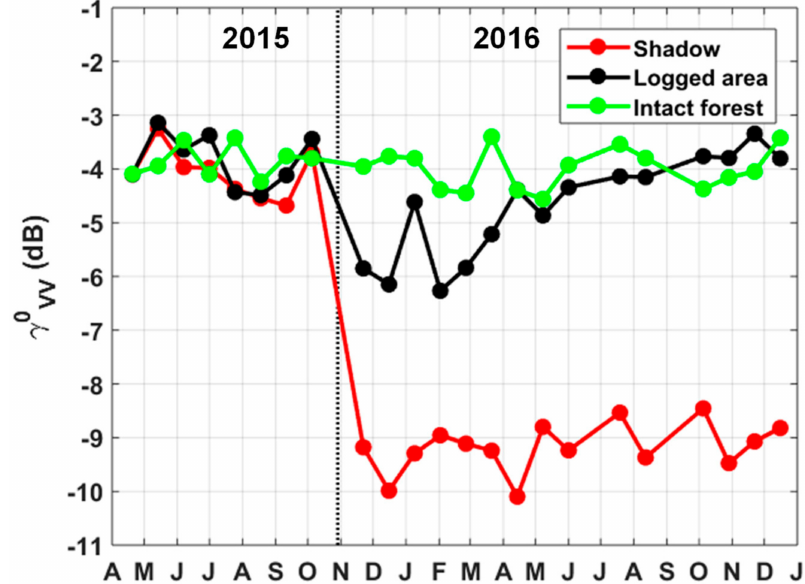
Figure 5. Temporal backscatter profiles of an area being logged (black), the corresponding shadow (red) that is created on one of its edges when deforestation occurs (October–November 2015), and an intact forest (green).